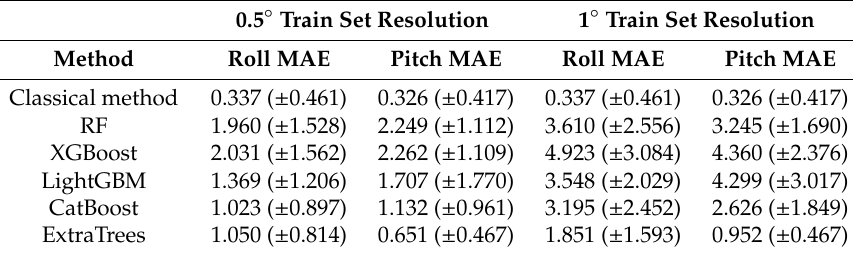
Table 6. CA wide range MAE (mrad) after 3 s of prediction